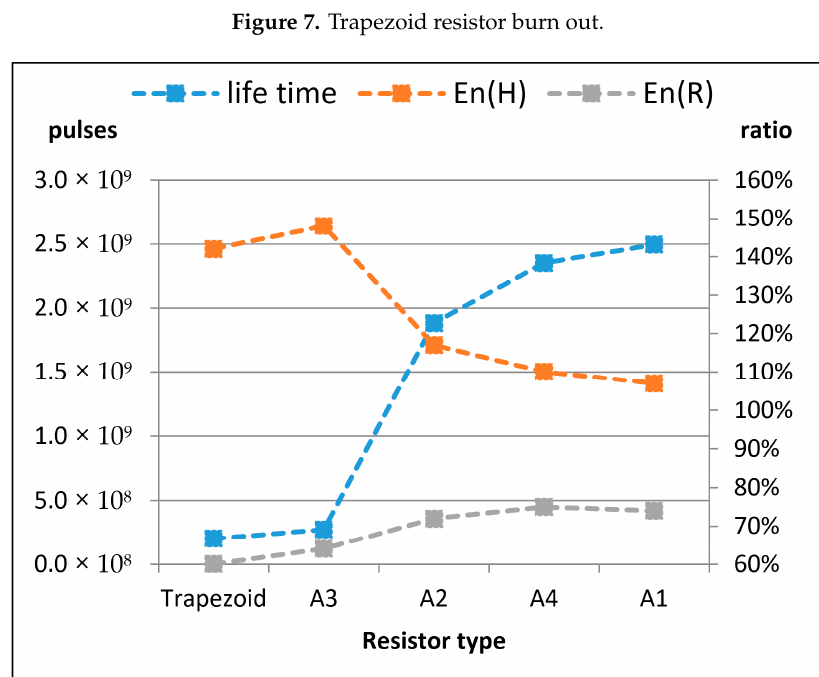
Figure 8. Experimental lifetime results and electric fields simulation results; the resistor shapes are shown in Figure